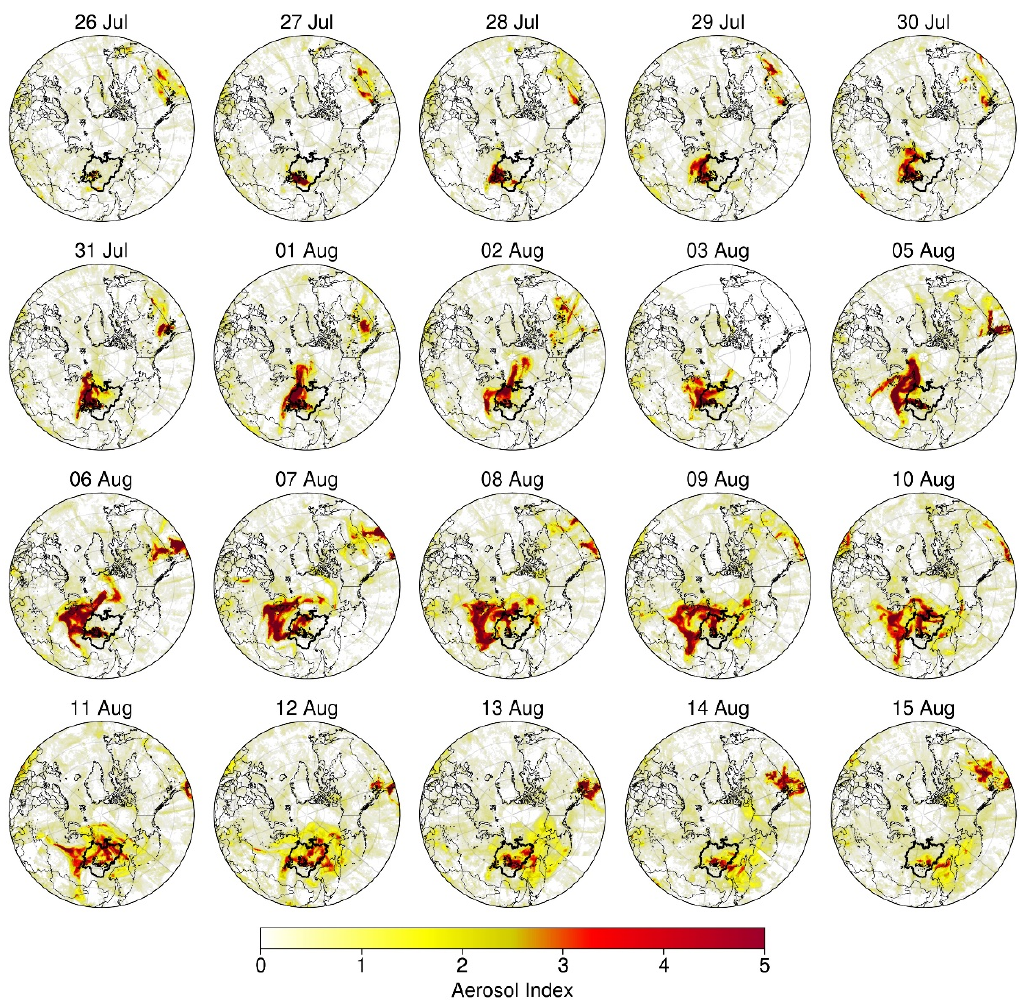
Figure 10. Spatial distribution of OMPS-NM aerosol index during the second period of wildfire intensification in the study region (26 July–15 August). The bold solid line indicates Yakutia administrative boundary, black dots—MODIS hotspots.